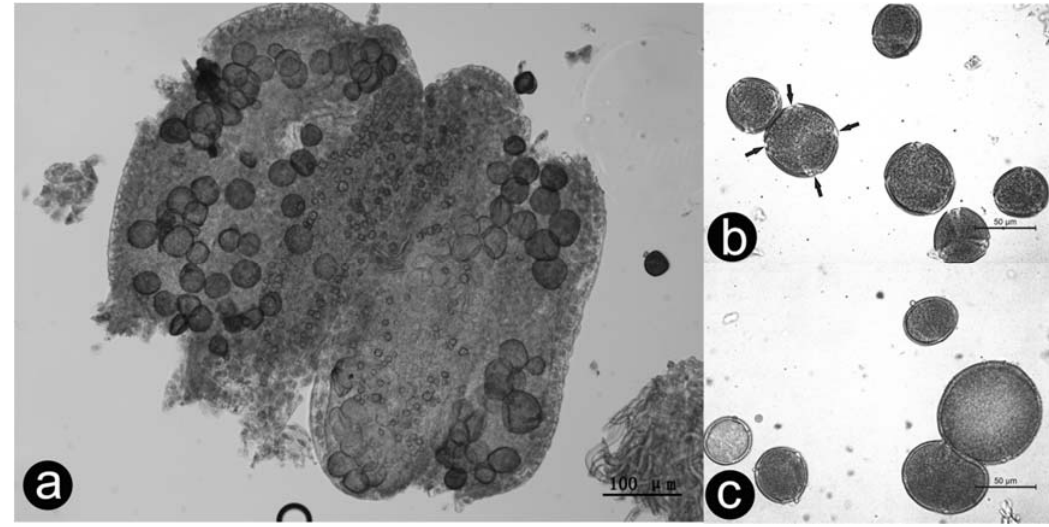
Figure 7 . Unreduced and reduced pollen grains. ( a ) Different ‐ sized pollen grains in anthers (scale bar = 100 μ m); ( b ) Unreduced pollen with four germ pores, in contrast to the three germ pores in normal pollen (scale bar = 50 μ m); ( c ) Giant pollen and reduced pollen (scale bar = 50 μ m).